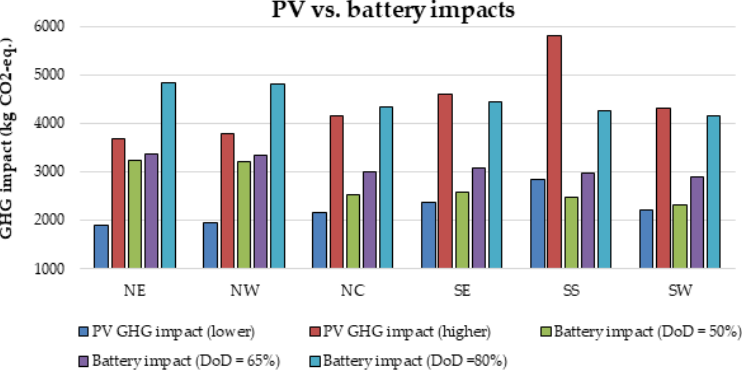
Figure 23. Effect of increased DoD on GHG